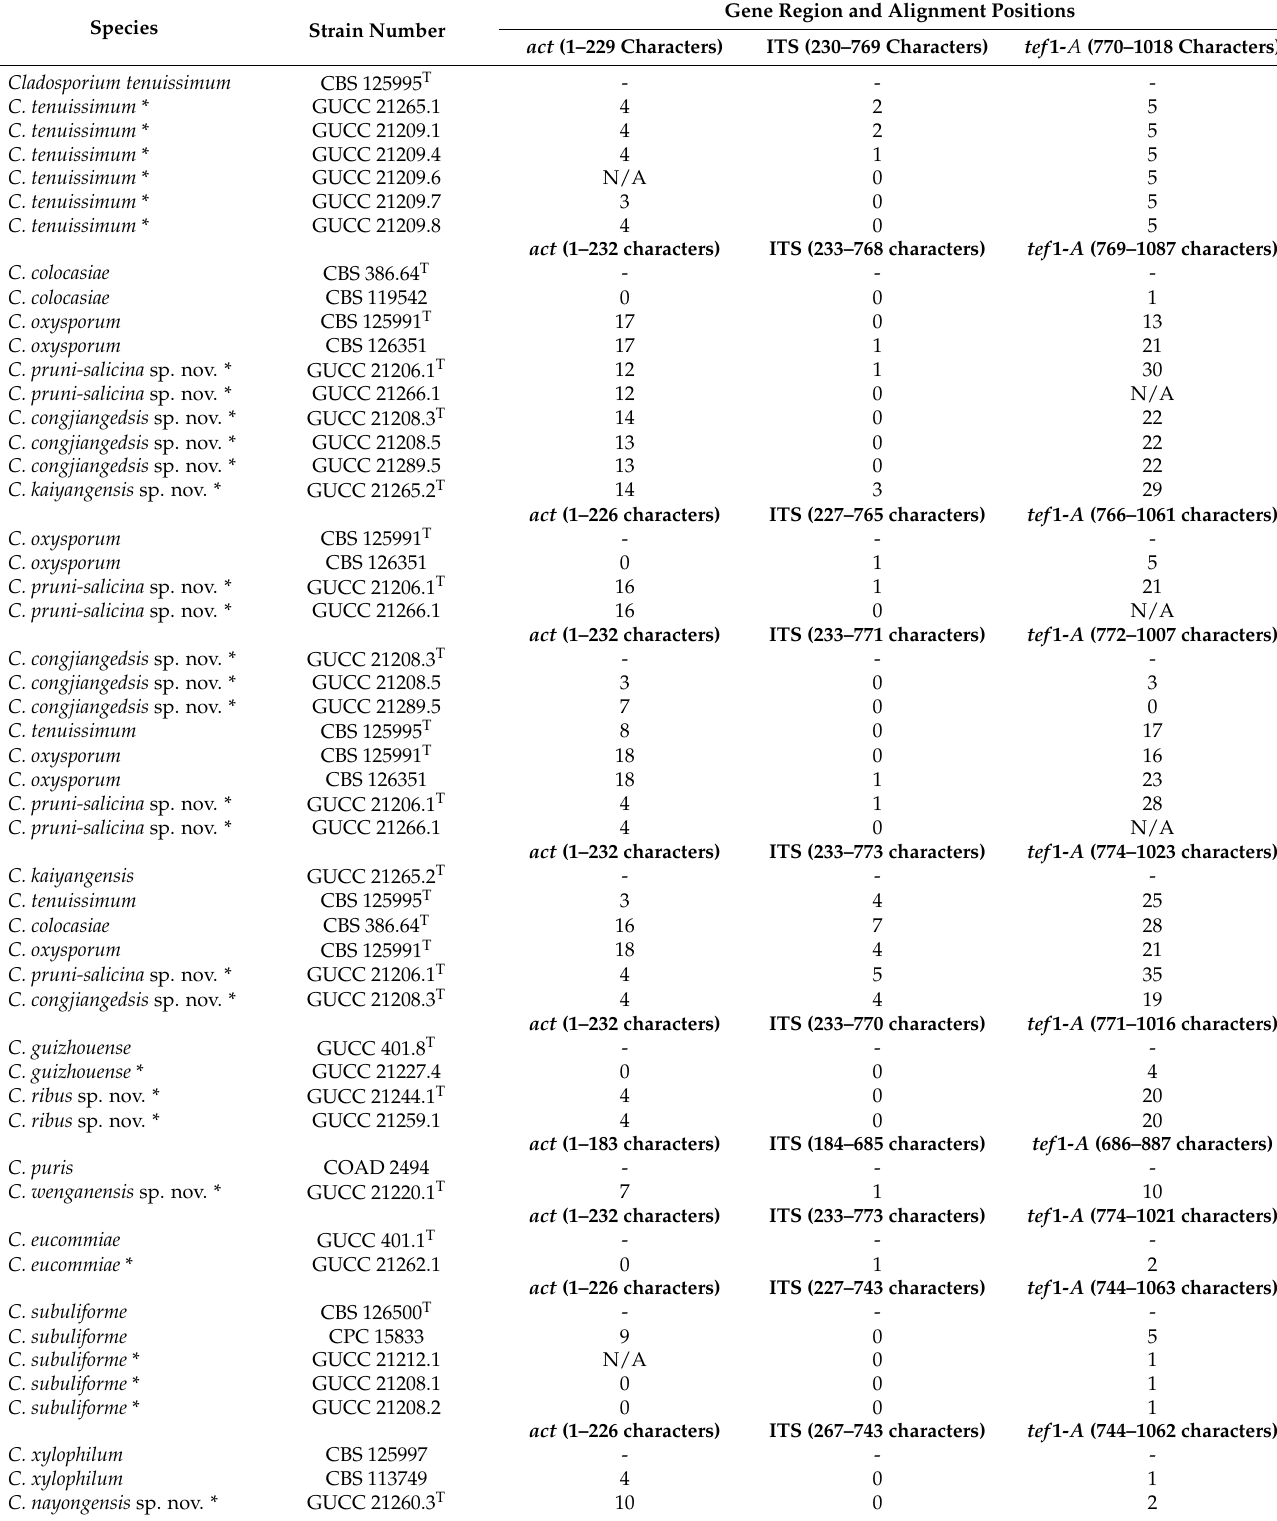
Table 3. DNA base differences between our strains and related taxa in the three gene regions (including gaps). Asterisks (*) denote our material, (T) = ex-type